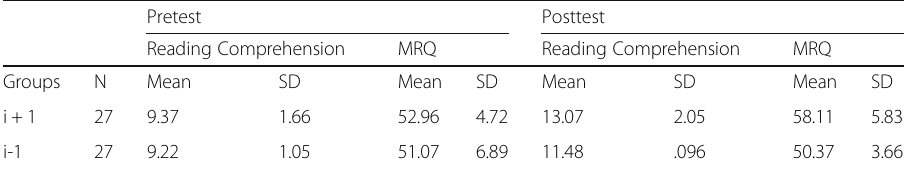
Table 4 Descriptive statistics of the ‘ i - 1 ’ and ‘ i + 1 ’ groups ’ responses to reading comprehension test and MRQ Pretest Posttest Reading Comprehension MRQ Reading Comprehension MRQ Groups N Mean SD Mean SD Mean